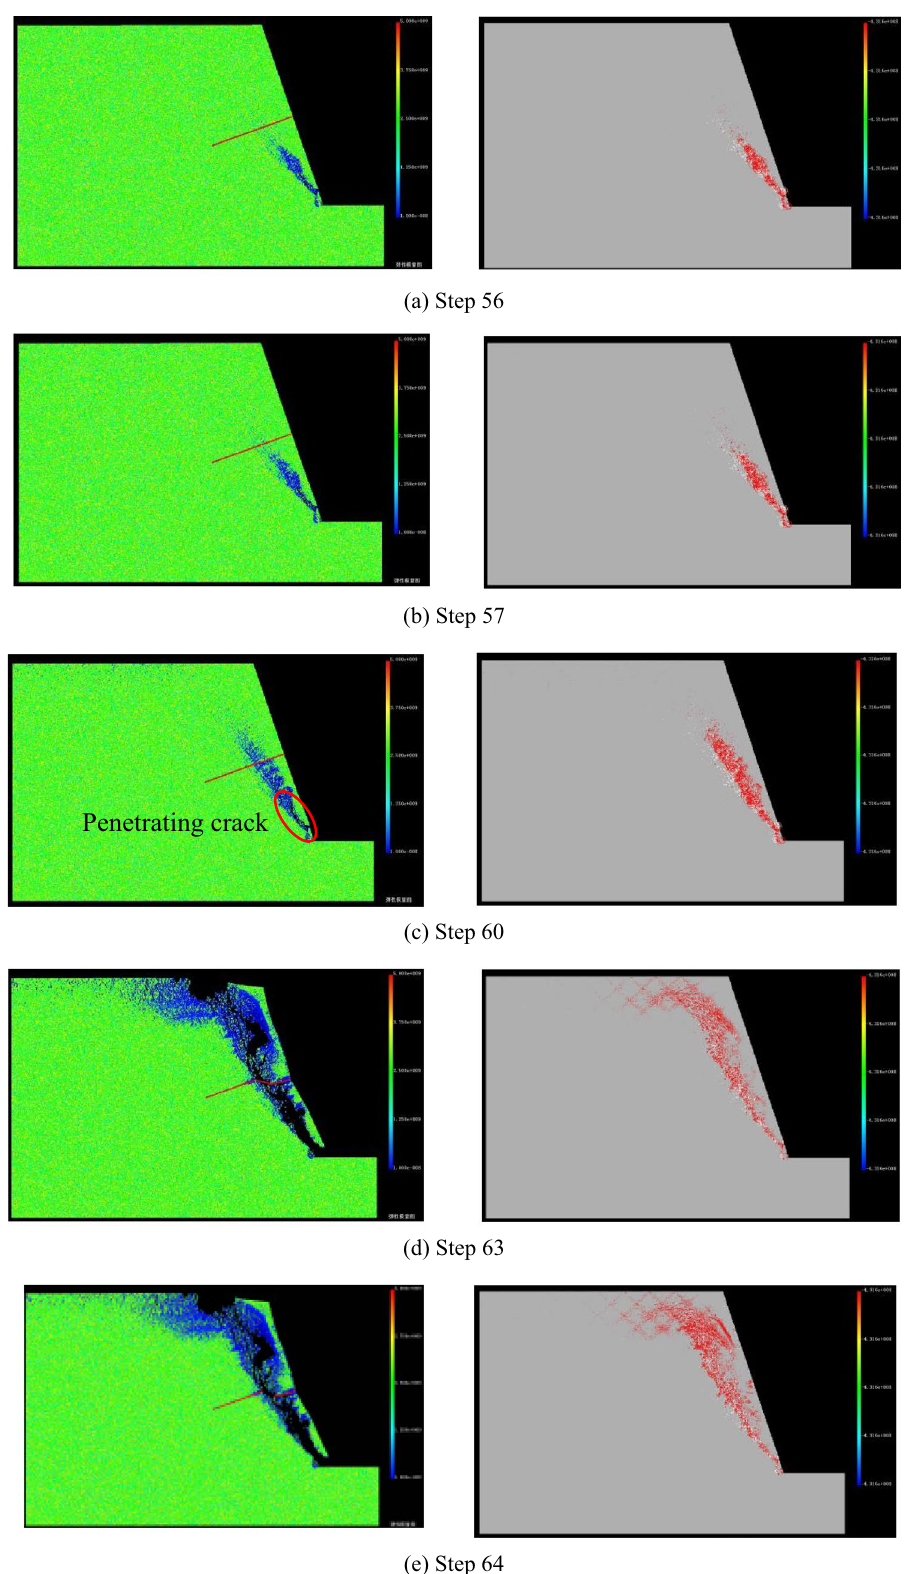
Figure 8. Landslide process (The left column is the elastic modulus diagram, the right column is the acoustic emission